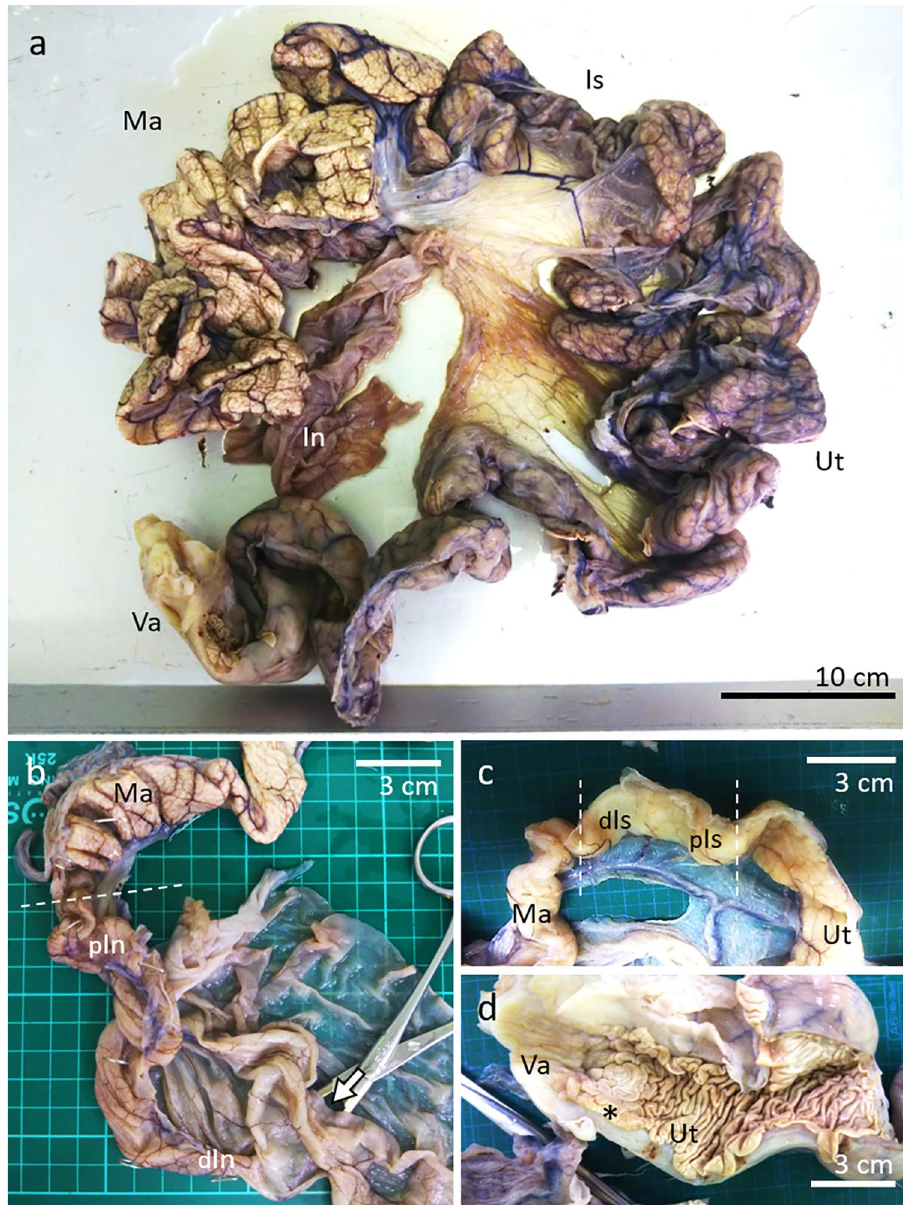
Figure 1. Morphological features of oviduct in green turtle (ID-035). ( a ) Image of entire oviduct from distal vagina to infundibulum. In infundibulum, Is isthmus, Ma magnum, Ut uterus, Va vagina. ( b ) High magnification of image near distal end of oviduct. Proximal (pIn) and distal (dIn) portions of infundibulum correspond to those in Fig. 2. Arrow, oviduct opening to abdominal cavity; Ma magnum. ( c ) High magnified image of transition area from Ut to Ma. Proximal (pIs) and distal (dIs) portions of isthmus correspond to those in Fig. 2. ( d ) *Internal views of transition area, correspond to Figs. 3 and 4, from (Va) to (Ut). Bars 10 ( a ) and 3 ( b–d )